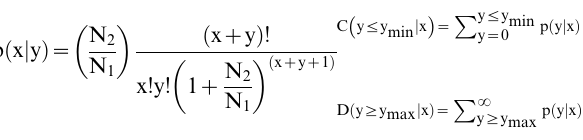
Figure S1 The work flow of Solexa sequencing. A. The experiment process. B. The whole data analysis process. Table S1 The detailed sequence information in Large White and Meishan small libraries. Table S2 Porcine miRNAs identified using Solexa sequencing. Table S3 Detailed information of known porcine miR- NAs in Large White and Meishan small libraries. Table S4 The sequences and secondary structures of predicted novel miRNAs in Large White and Meishan small libraries. Table S5 Single nucleotide substitution in seed region in both small RNA